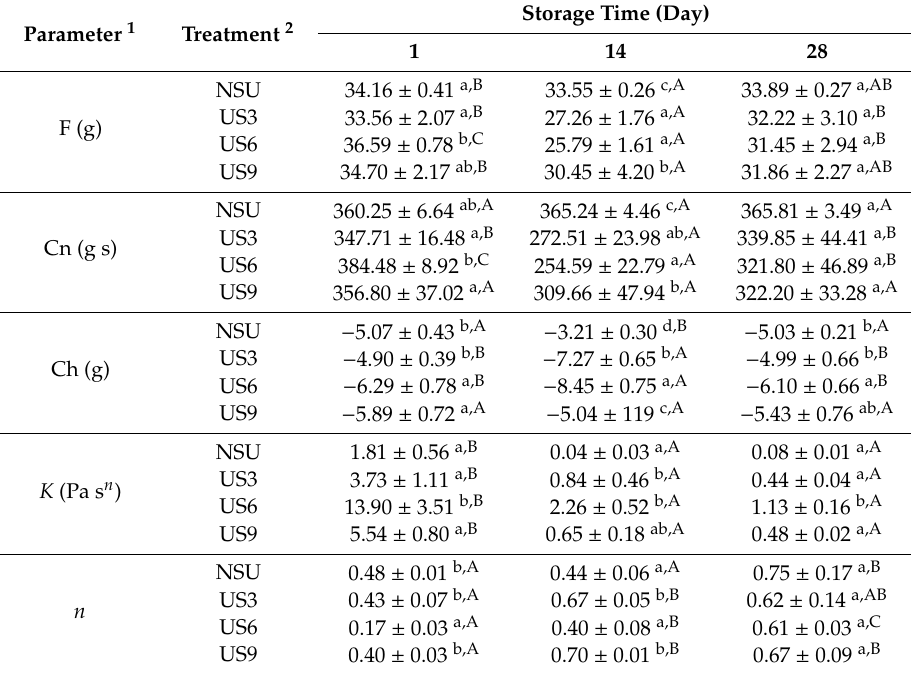
Table 4. Texture profile analysis and rheological characteristics of goat milk yogurt samples measured during 28 days of storage at 4 ◦